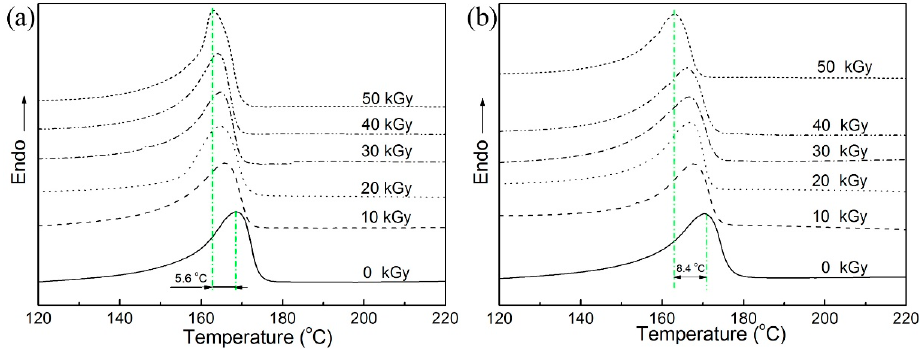
Figure 2. Differential scanning calorimetry (DSC) curves of the melting transition of PP samples at different doses: ( a ) pristine PP and ( b ) PP/TAIC (2 wt %).